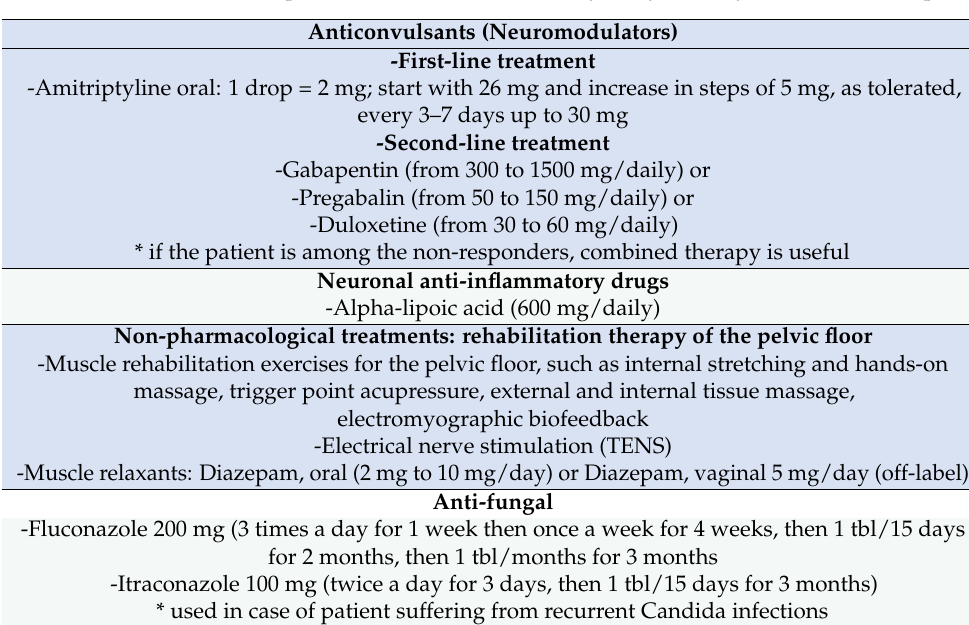
Table 2. Recommended therapies for the treatment of vulvodynia by Vulvodynia Network Group [45]. Anticonvulsants